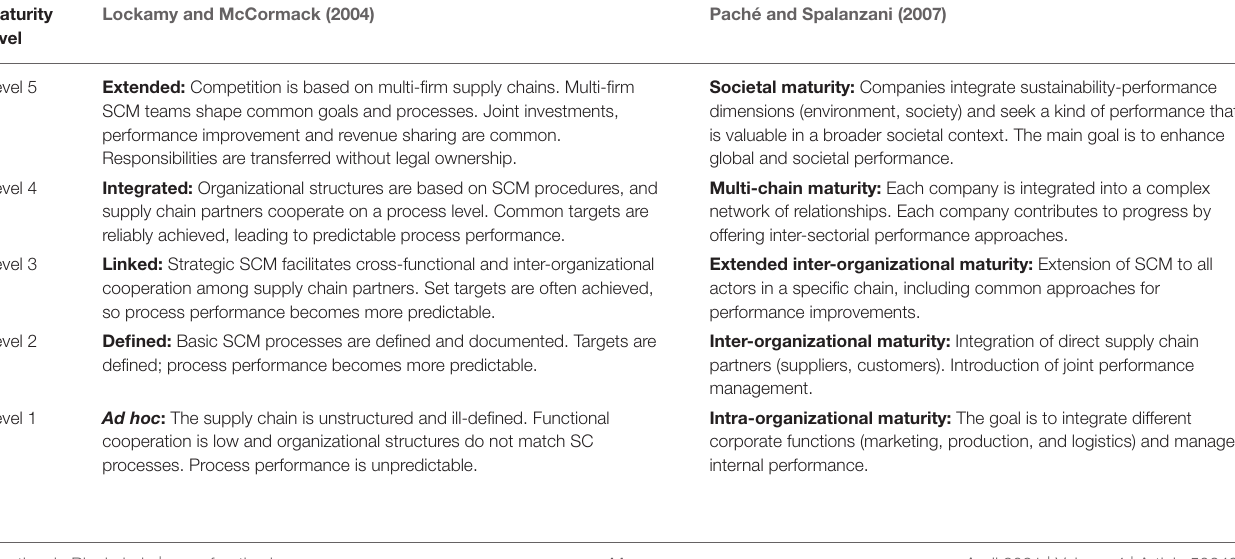
TABLE 3 | SCM maturity models [based on Lockamy and McCormack (2004) and Paché and Spalanzani